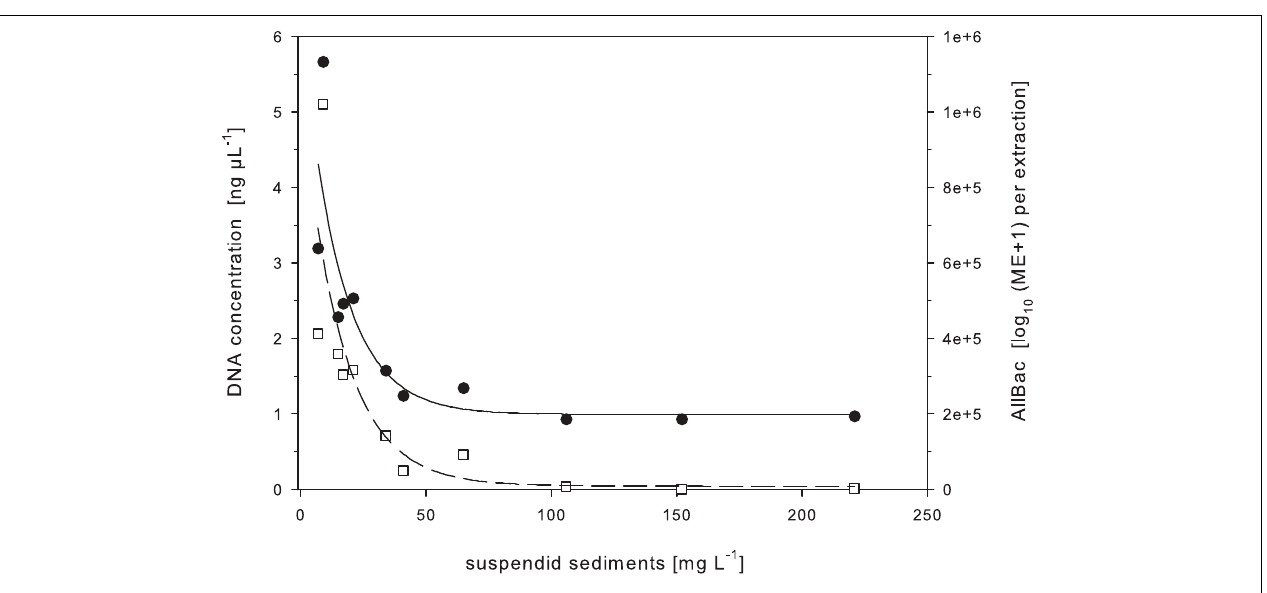
FIGURE 2 | DNA yield (black circles) and AllBac marker concentrations (white squares) in dependence of in lake water suspended lakebed sediments. ME, marker equivalents. n = 1 per sediment concentration.